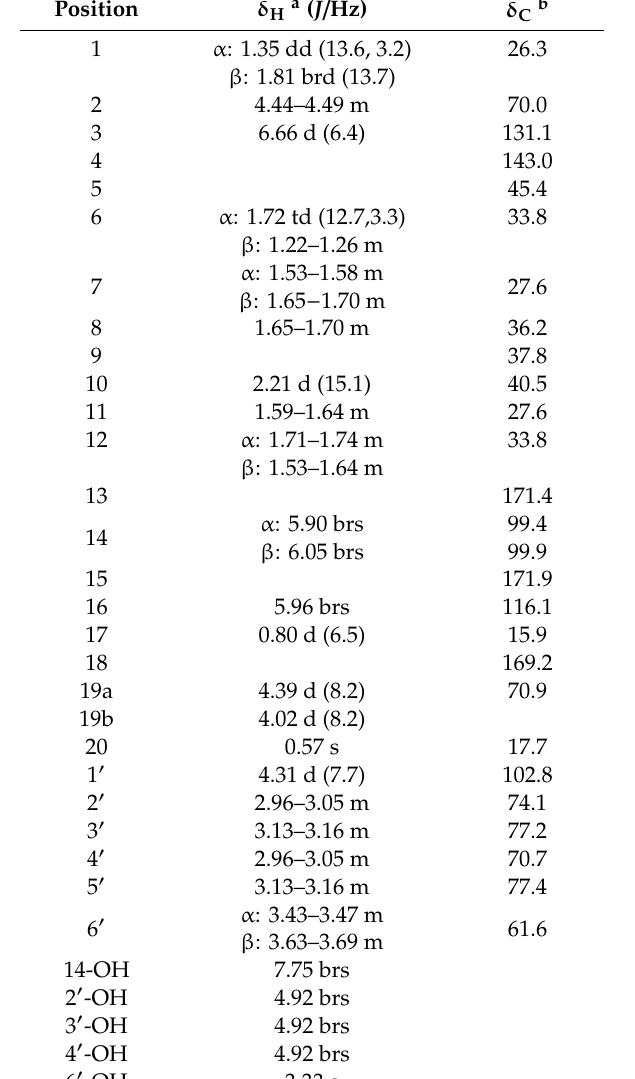
Table 1. 1 H and 13 C NMR spectroscopic data for compound 8a , b in DMSO- d 6